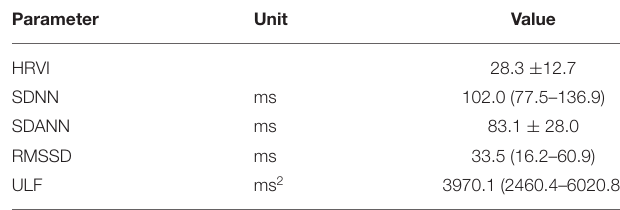
TABLE 2 | Measures of heart rate